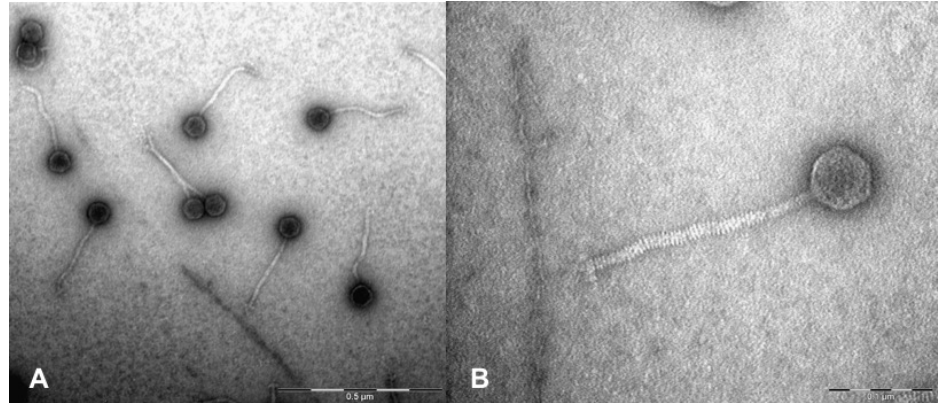
Figure 1. Electron micrographs of negatively stained AchV4 particles. ( A ) TEM micrograph showing CsCl-purified AchV4 virions (the scale bar corresponds to 0.5 µ m); ( B ) a close-up view of an AchV4 particle (the scale bar corresponds to 0.1 µ m).